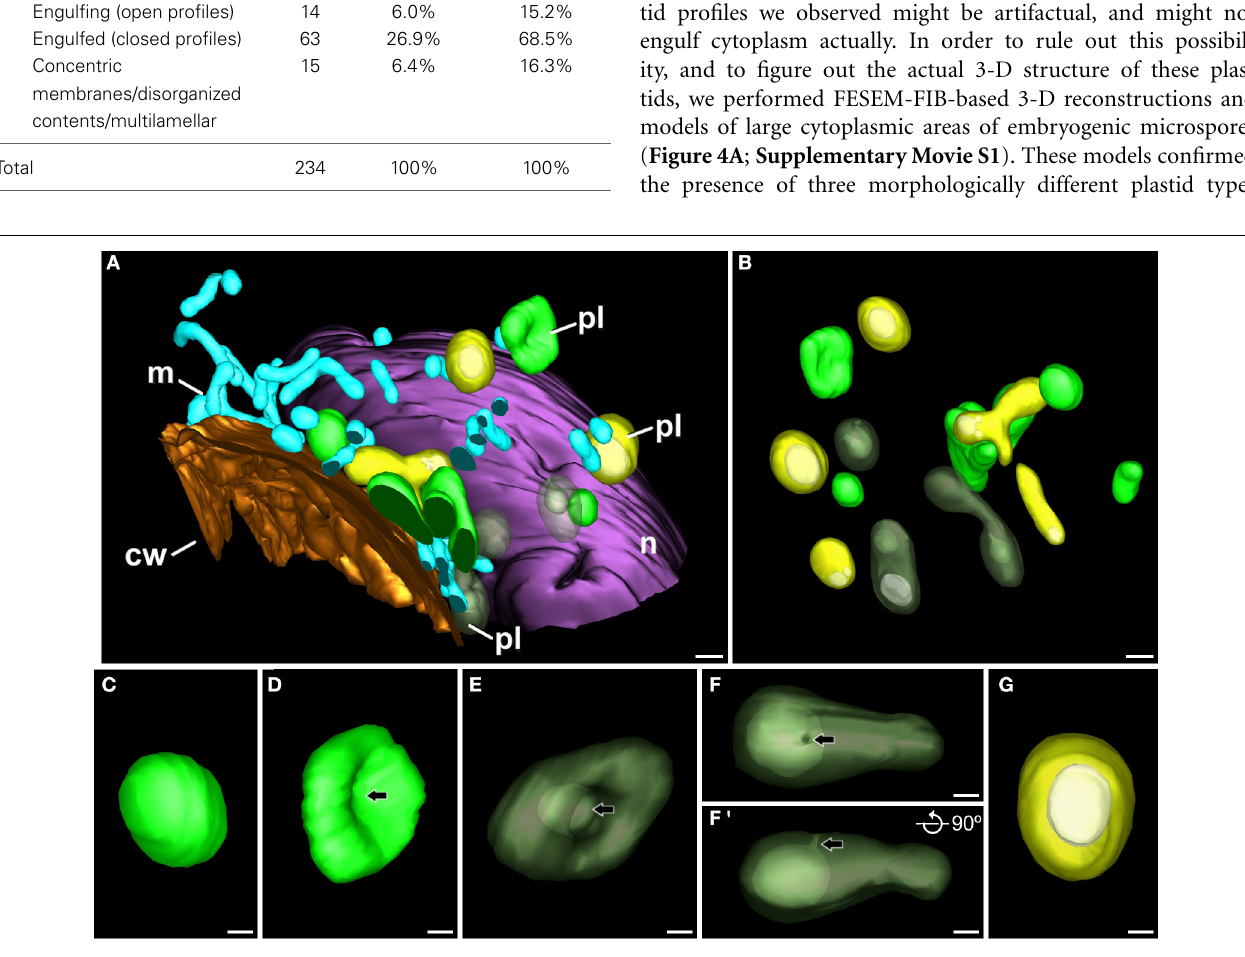
FIGURE 4 | 3-D model of a subcellular volume of a B. napus embryogenic microspore. (A) Modeled subcellular volume. (B) Model excluding all the cell structures but the plastids (pl). The different plastid types are modeled in different colors: conventional (light green), open profiles engulfing cytoplasm (dark green), and closed profiles (yellow) with the engulfed cytoplasm (white). (C) Conventional, round-shaped plastid. (D) Disc-shaped plastid with a slight central depression (arrow). (E) Plastid starting to engulf cytoplasm. The arrow points to a deep depression that